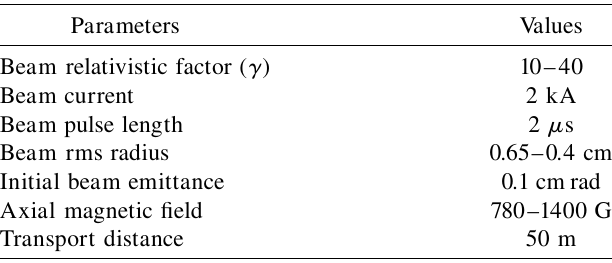
TABLE III. Parameters for accelerated beam simulations. Parameters